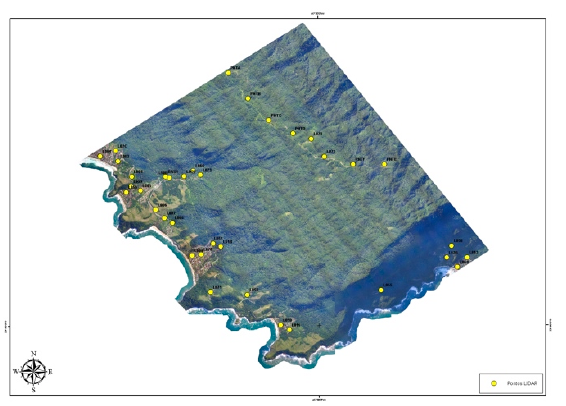
Figure 2: Distribution of ground check points on the mosaic of